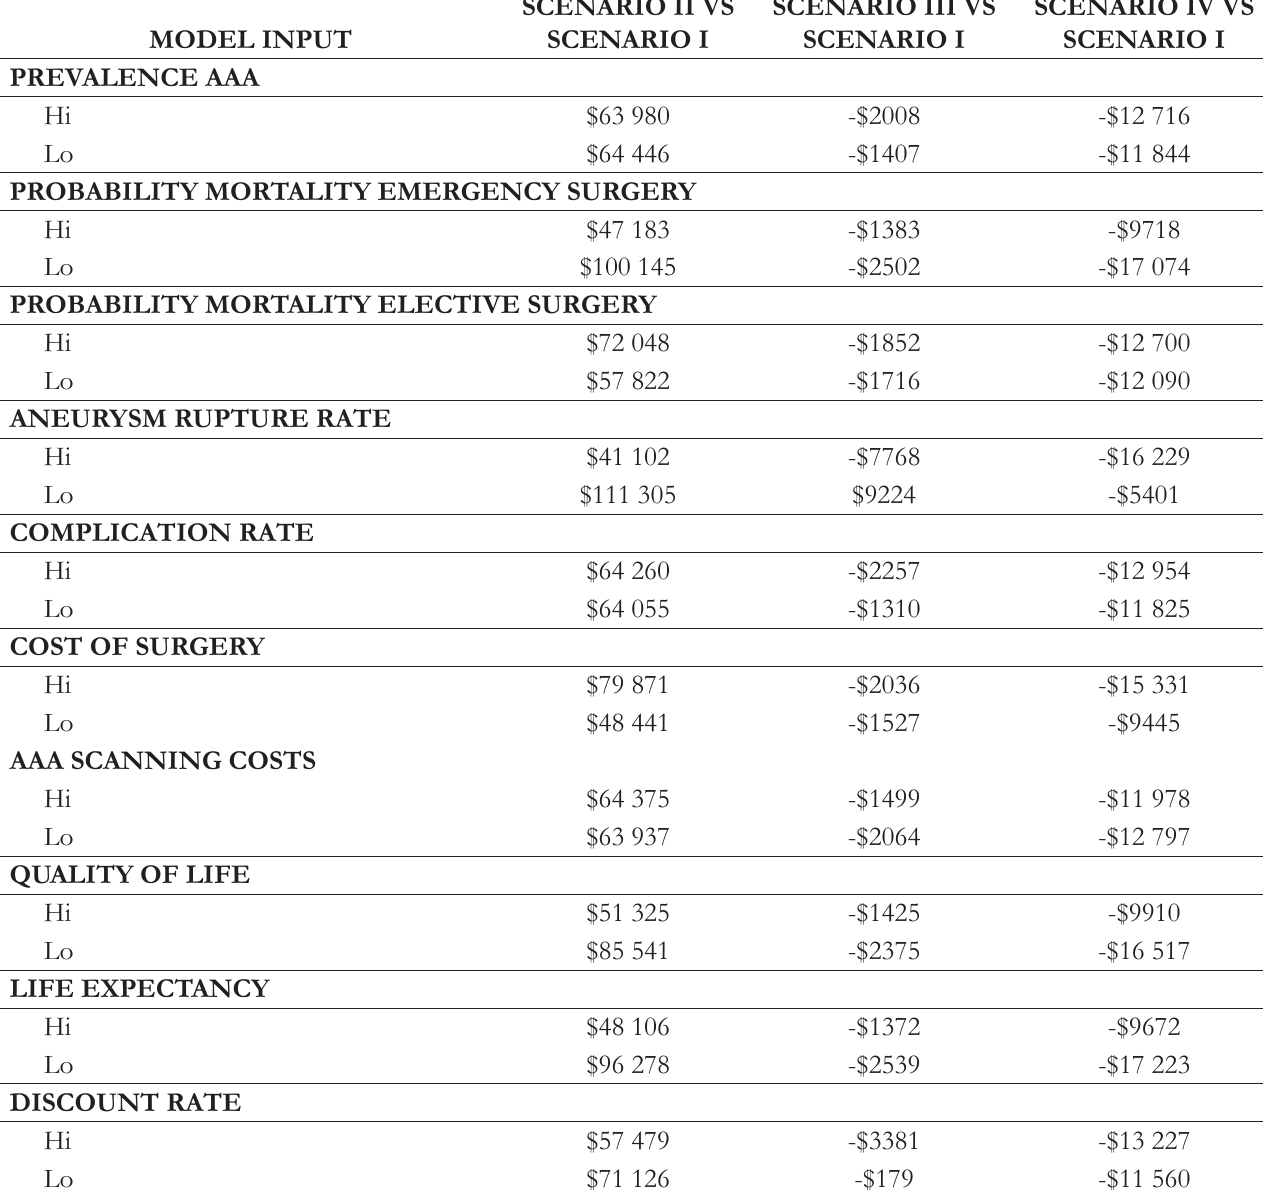
Table 4. One-way Sensitivity Analysis: Incremental Cost/QALY Under Alternative Model Input